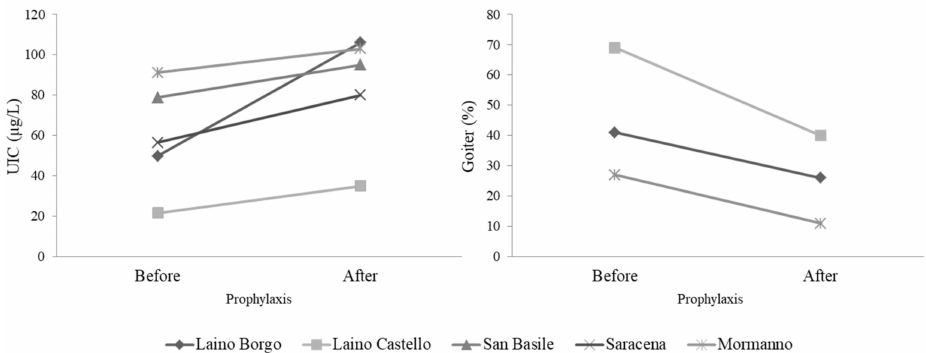
Figure 2. Urinary iodine concentration (UIC) and goiter prevalence before and after iodine prophylaxis in schoolchildren of the Cosenza